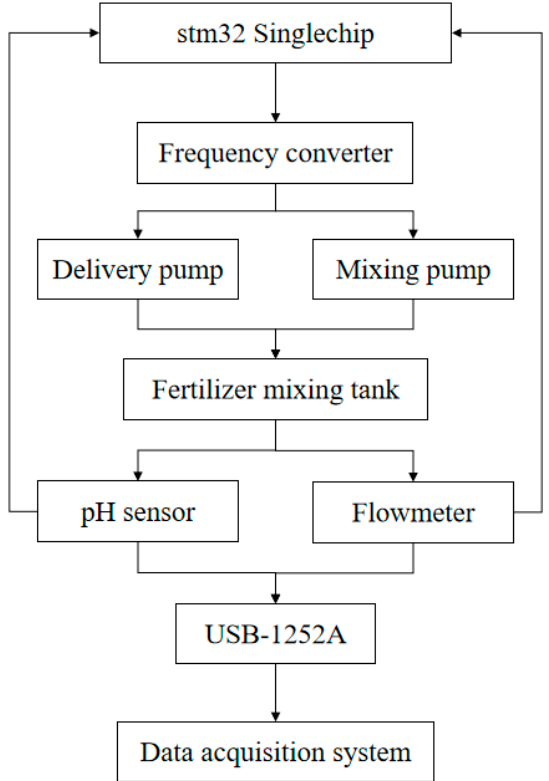
Figure 16. Schematic diagram of data acquisition and control system.